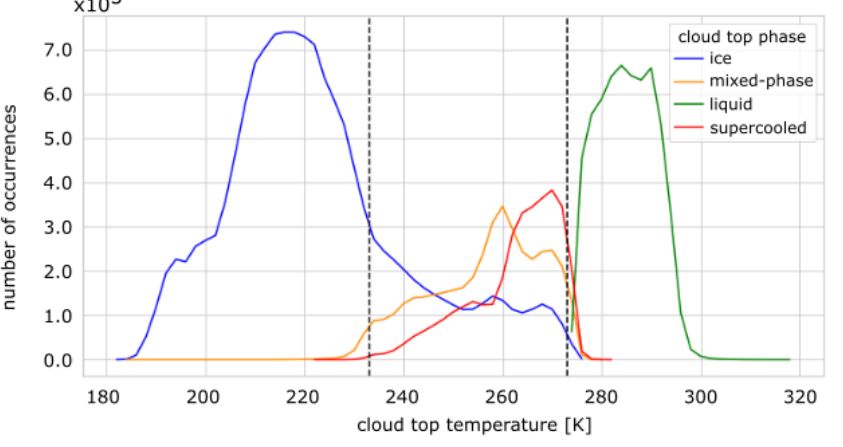
Figure 4. Number of occurrences of SEVIRI-like CTP as a function of cloud top temperature (CTT). The distribution has bins of 1.0 K. Black dashed lines indicate the temperatures 233 K and 273